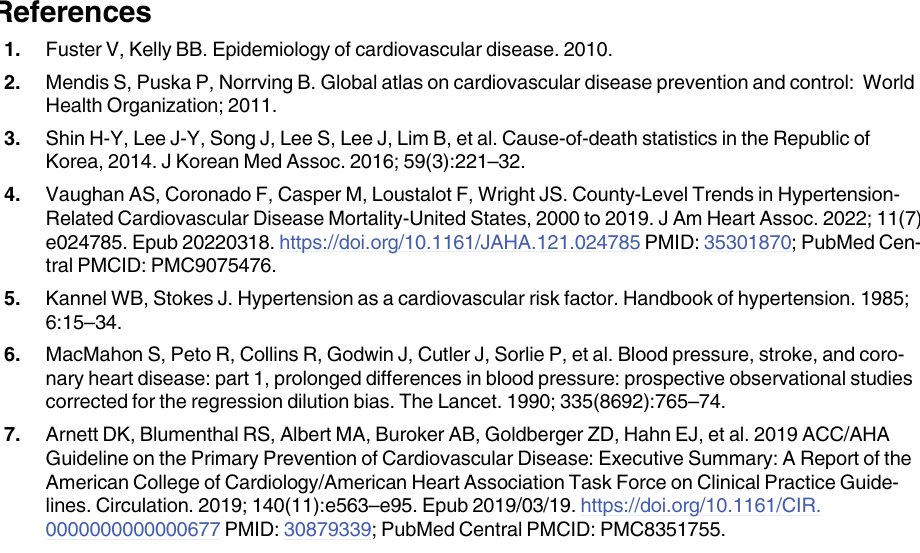
S3 Table. The association with systolic blood pressure on different specific categories for the risk of mortality in the Korean Multi-center Cancer Cohort study over 15 follow-up years. S4 Table. The association with diastolic blood pressure on different specific categories for the risk of mortality in the Korean Multi-center Cancer Cohort study over 15 follow-up